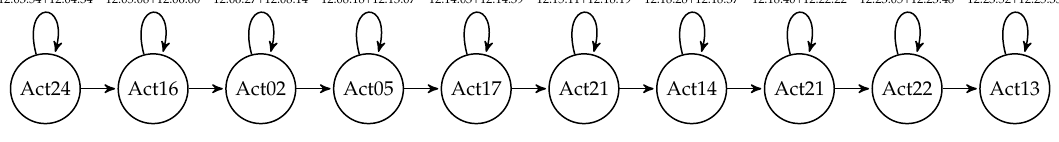
Figure 6. User: Mario, Date: 19 December, Type: